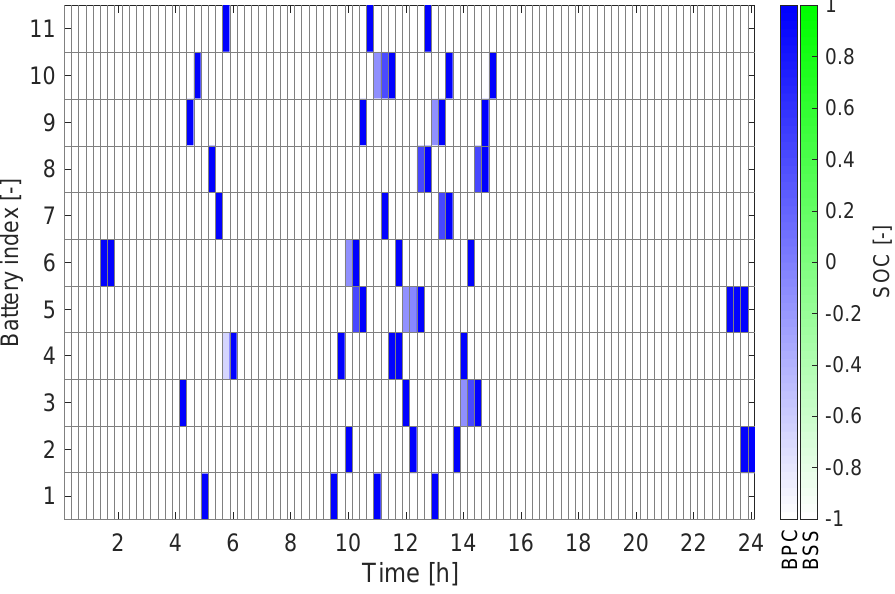
Figure 4. Battery state of charge time evolution at LIMB for the Most Demanding Day case (BPC